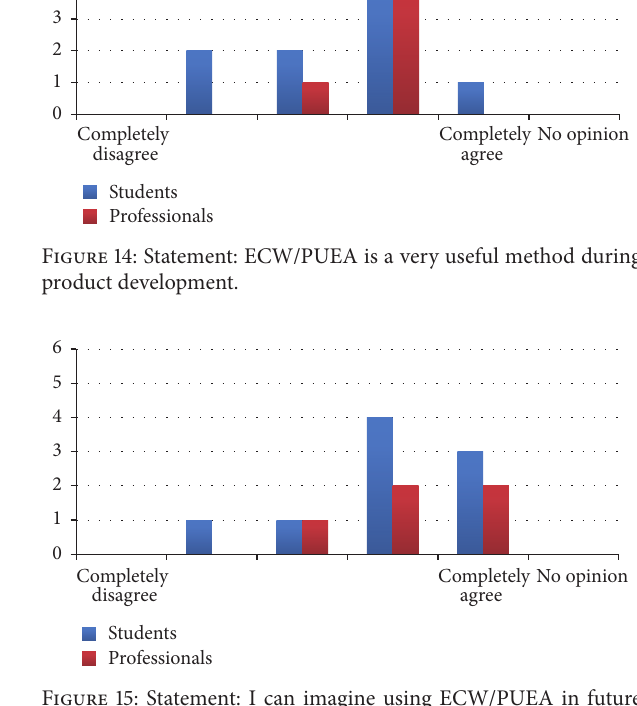
Figure 13: Statement: ECW/PUEA feels like a very serious method.